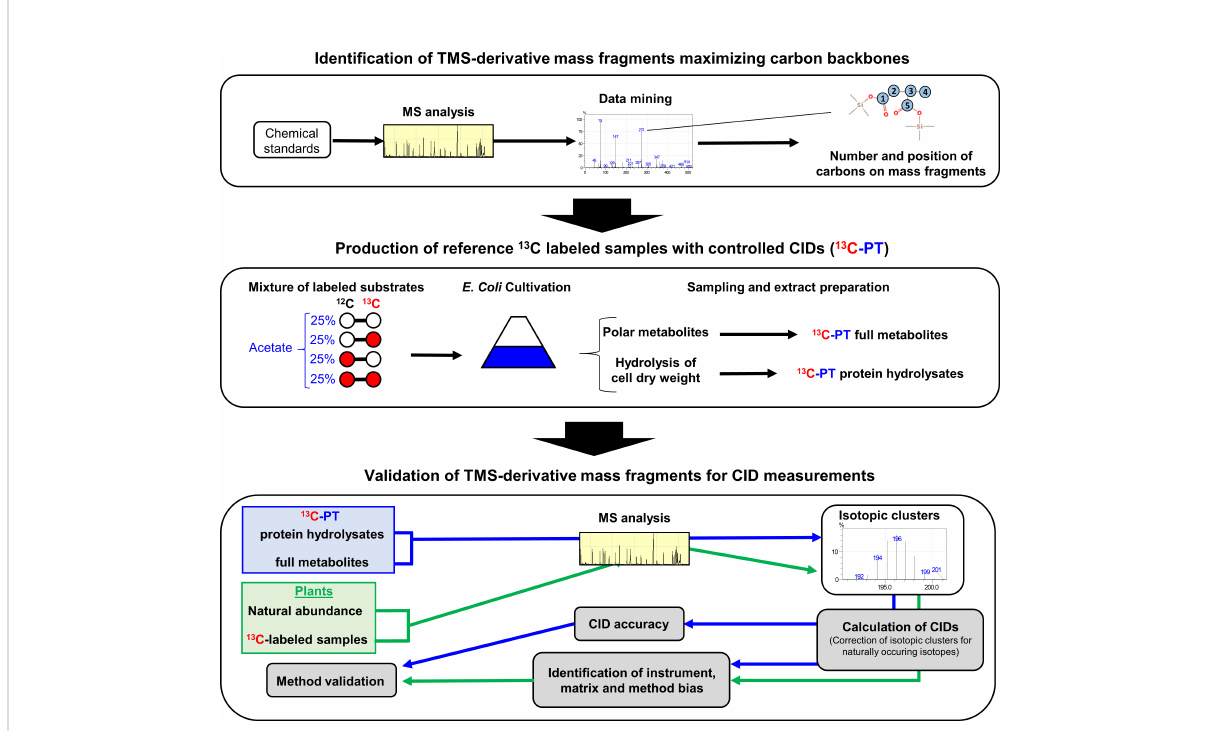
FIGURE 1 Work fl ow used in this study. A GC-MS method was built with abundant molecular ions deriving from TMS-derivatives of organic and amino acids that contained a large number of informative carbons. Then this method was evaluated by using: i) chemical standards and tailor-made 13 C-standards that had a predictable CID using E. coli as a metabolic factory ( 13 C-PT); ii) unlabeled and 13 C-labeled plant